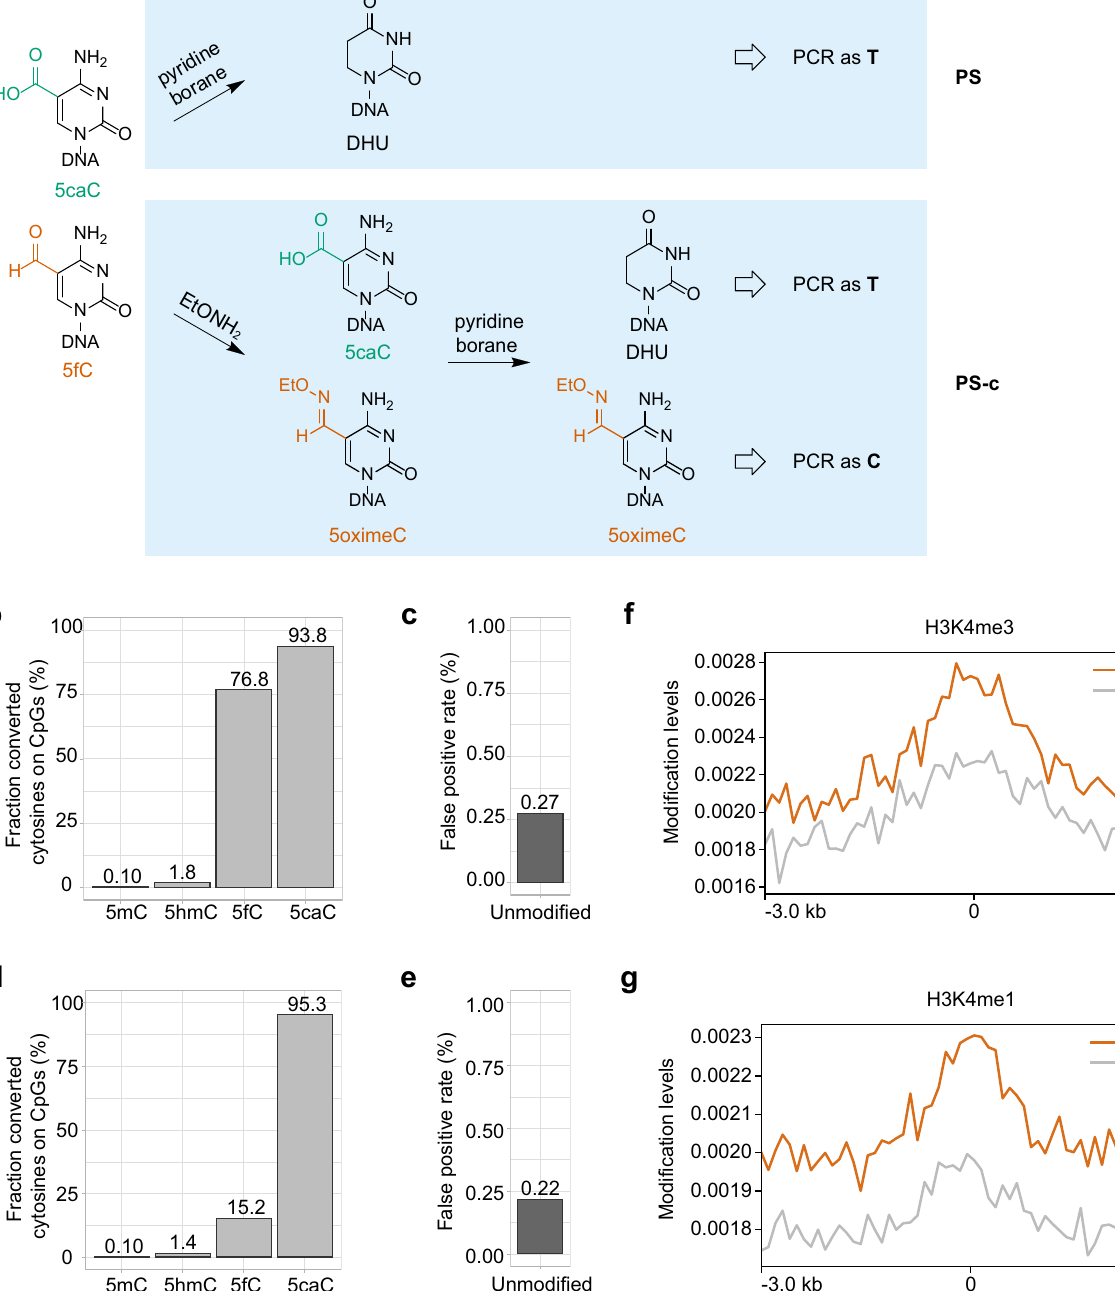
Fig. 4 PS for bisul fi te-free 5fC/5caC-speci fi c sequencing. a Schematic demonstration of PS and PS-c. b Conversion rate of PS at known 5mC, 5hmC, 5fC, and 5caC positions in spike-in controls. c False-positive rate of PS from 2-kb-unmodi fi ed spike-in. d Conversion rate of PS-c at known 5mC, 5hmC, 5fC, and 5caC positions in spike-in controls. e False-positive rate of PS-c from 2-kb-unmodi fi ed spike-in. f , g Average 5fC/5caC signal in the 6-kb regions fl anking the centers of H3K4me3 ( f ) and H3K4me1 ( g ) peaks produced by the ENCODE Project Consortium. On the x-axis, 0 denotes the peak